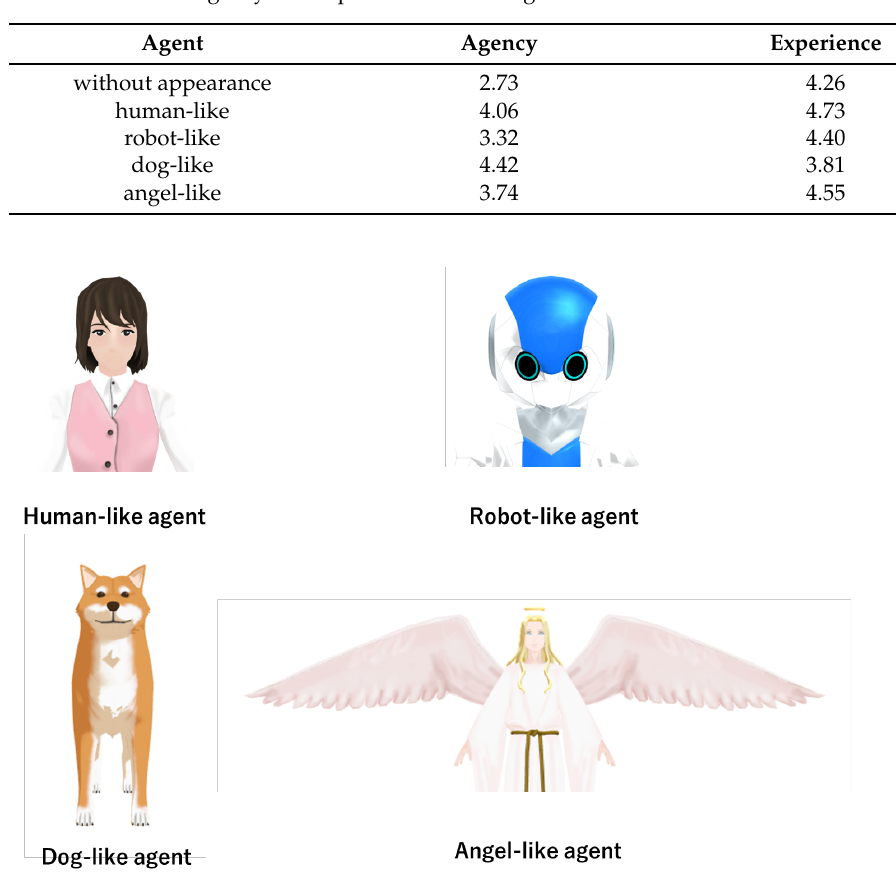
Figure 1. Virtual agents that we used in the